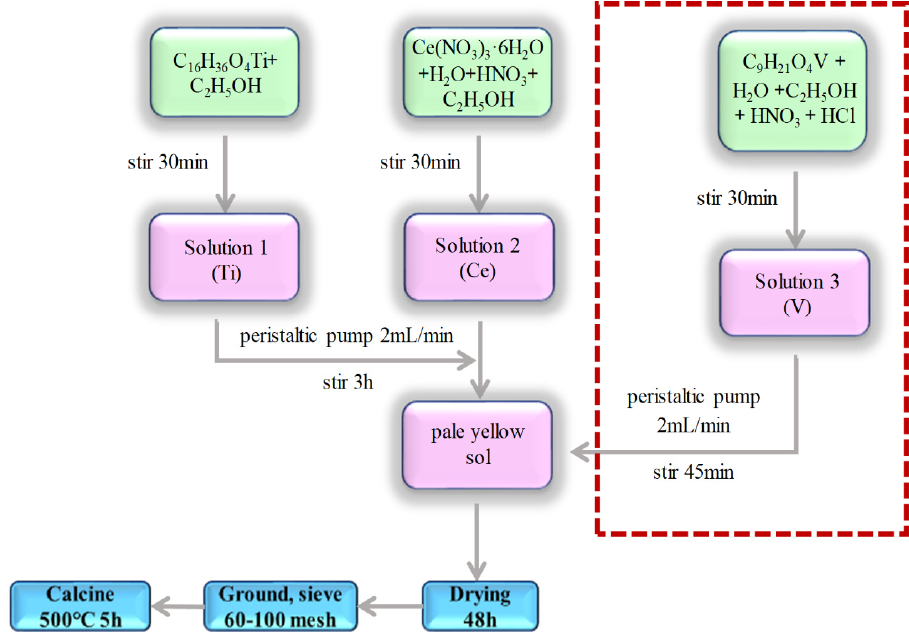
Figure 1. Operation procedures of catalyst preparation by sol–gel method.